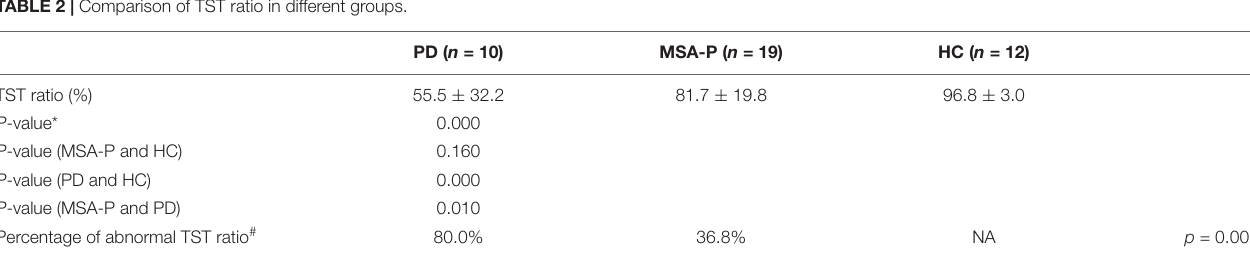
TABLE 2 | Comparison of TST ratio in different